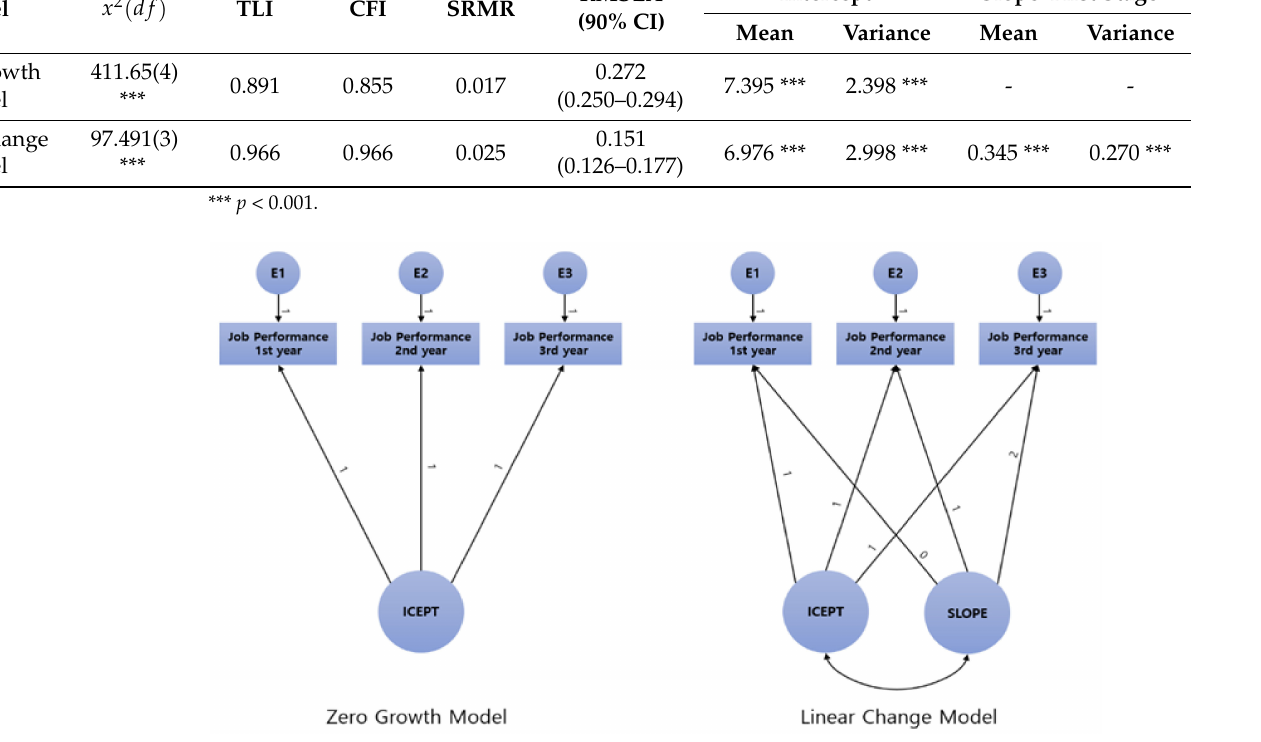
Figure 3. Schematic diagrams of the zero-change model and the linear change